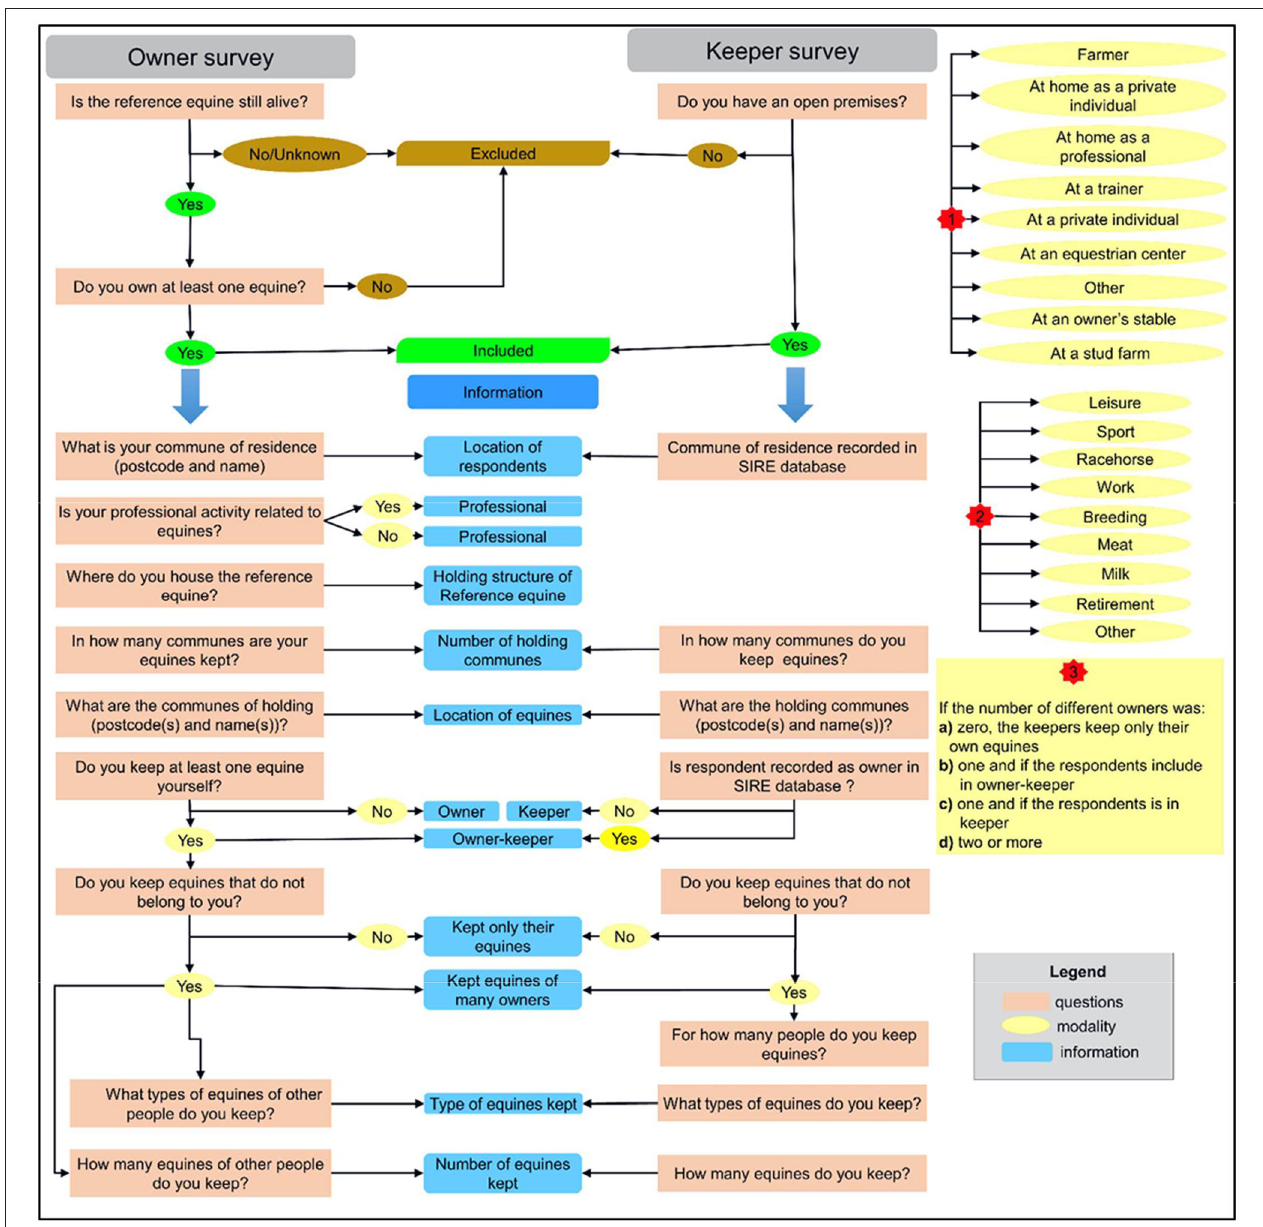
FIGURE 1 | Structure of questionnaires, information, and decision rules.